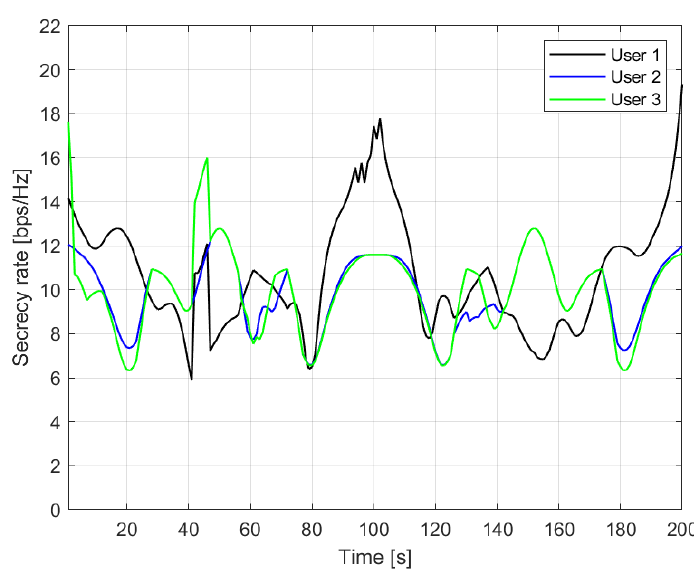
Figure 8. Average secrecy rate versus simulated